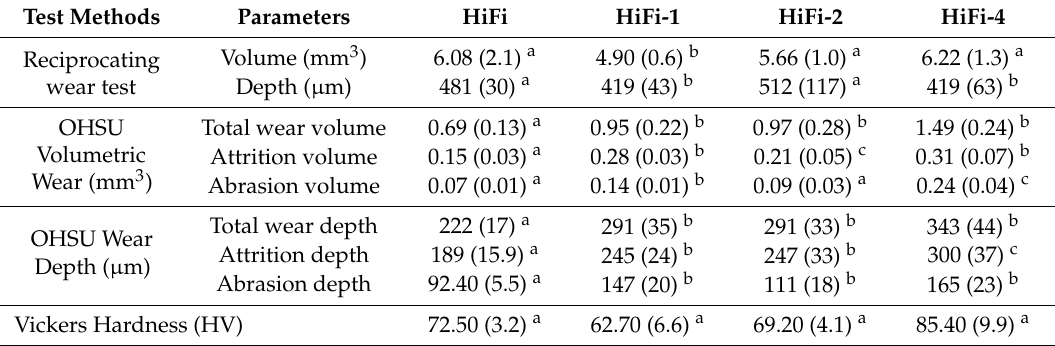
Table 3. Hardness and wear data of HiFi cements reinforced with nanoclays ( p <